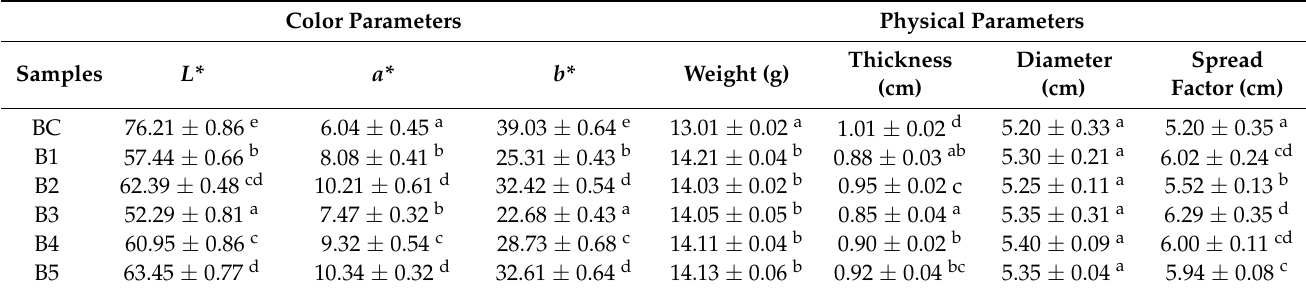
Table 8. Color and physical characteristic of cookies.